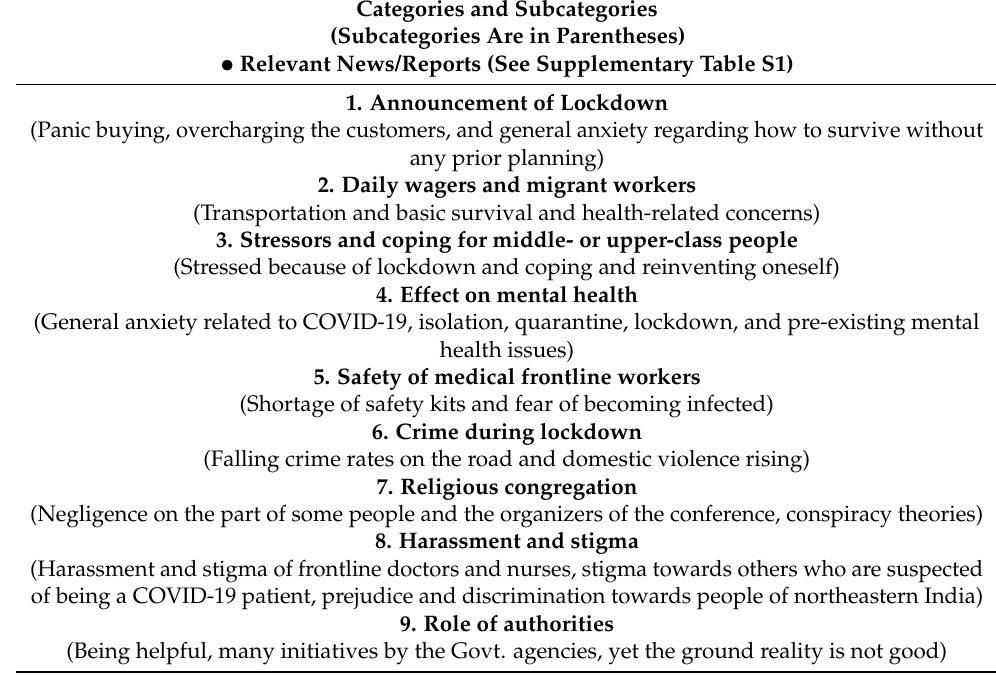
Table 1. Categories and subcategories are identified in the content analysis. Categories and Subcategories (Subcategories Are in